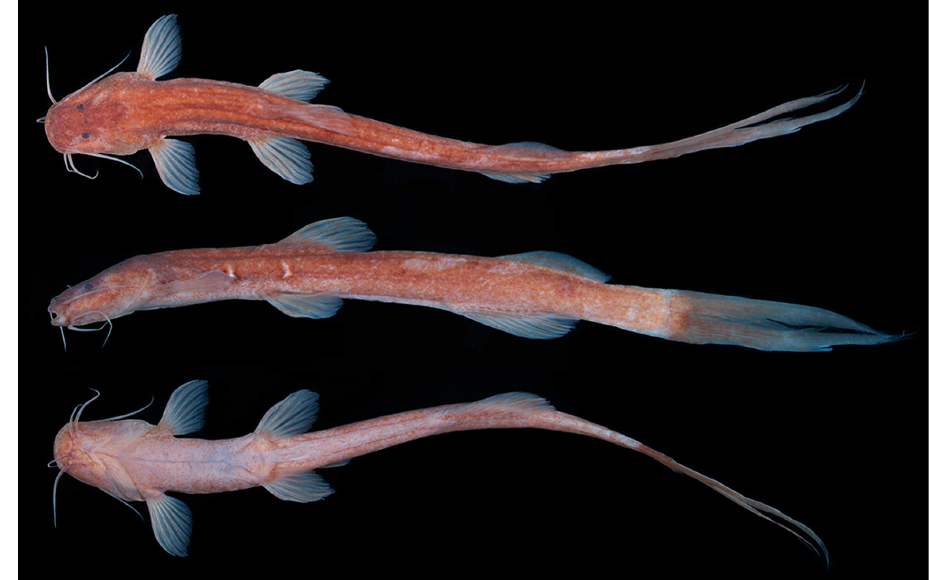
FIGURE 1 | Phenacorhamdia suia , MNRJ 24850, holotype, 81.8 mm SL, Brazil, Mato Grosso State,